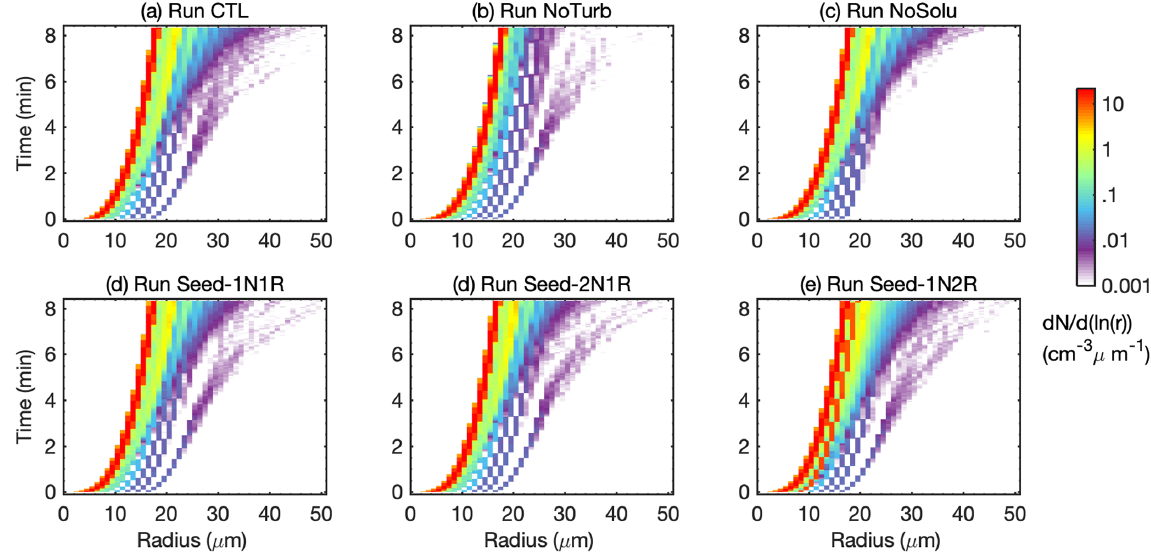
Figure 3. Time evolution of the droplet size distribution in the condensation–collision set of experiments. The droplet number concentration (cm − 3 ) is indicated by colors with its value shown in the color bar. The configuration of each experiment is listed in Table